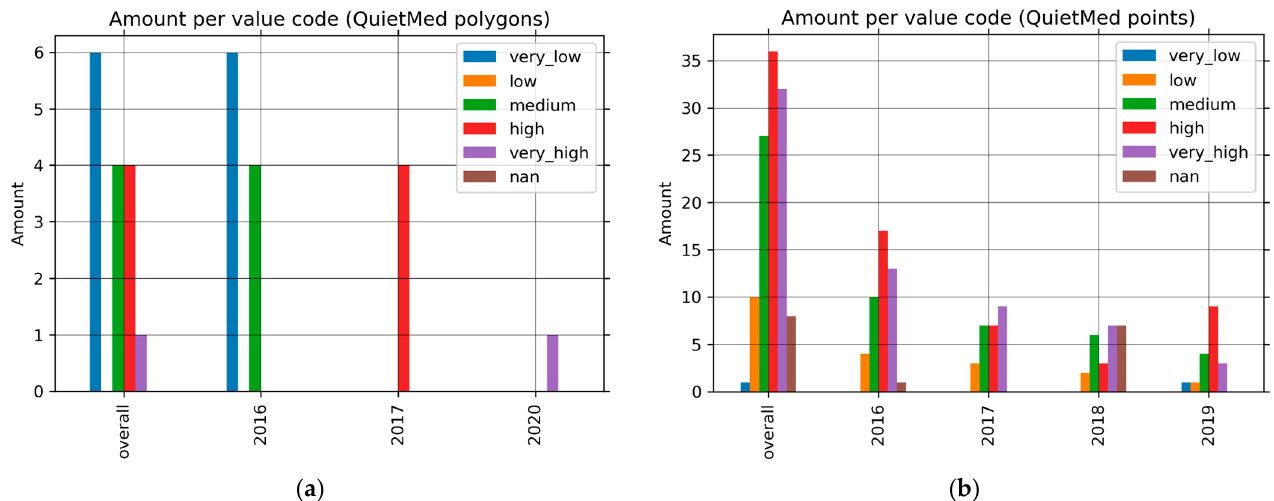
Figure A2. ( a ) Value code per year within INR-MED polygons dataset; ( b ) Value code per year within INR-MED points dataset.